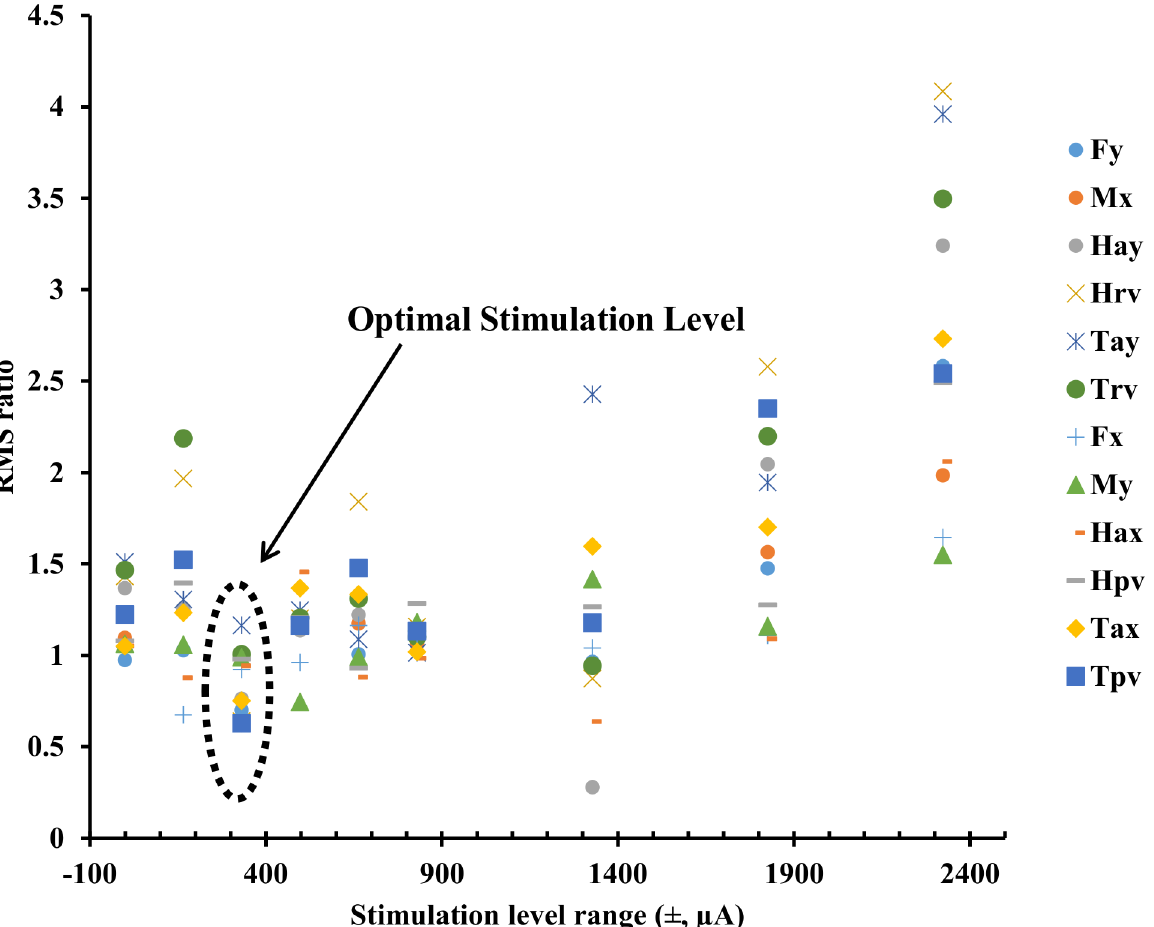
Fig 2. Ratio data of all twelve measures of RMS during the stimulus period to the RMS during the baseline period at different stimulus level ranges, for the same subject as in Fig 1. Note that for this subject, performance improved in all directions (ML, AP, and APML) at the same stimulus amplitude range of ± 350 μ A. Further, this subject had to be assisted to prevent falling and did not complete trials at the two highest nominal stimulation levels tested ( ± 2800 μ A, ± 3300 μ